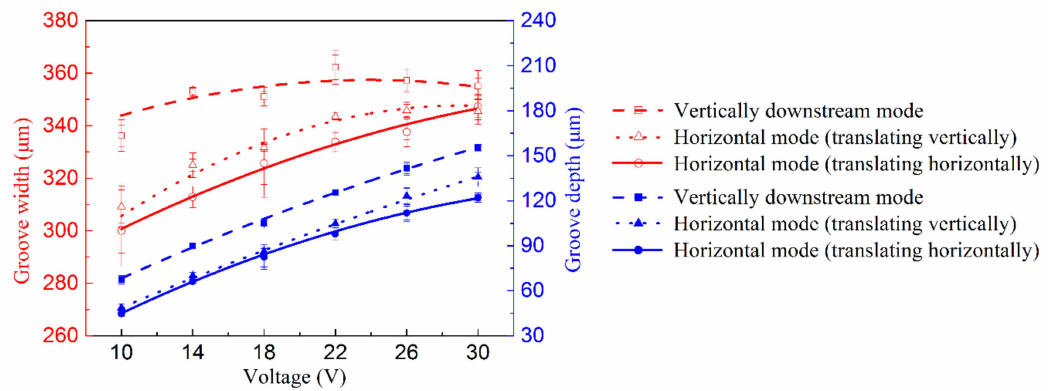
Figure 16. Change of geometric dimensional features (width, depth) of the machined micro-grooves when the translating speed was 200 µ m / s, the nozzle’s inner diameter was 170 µ m, and the working gap was 100 µ